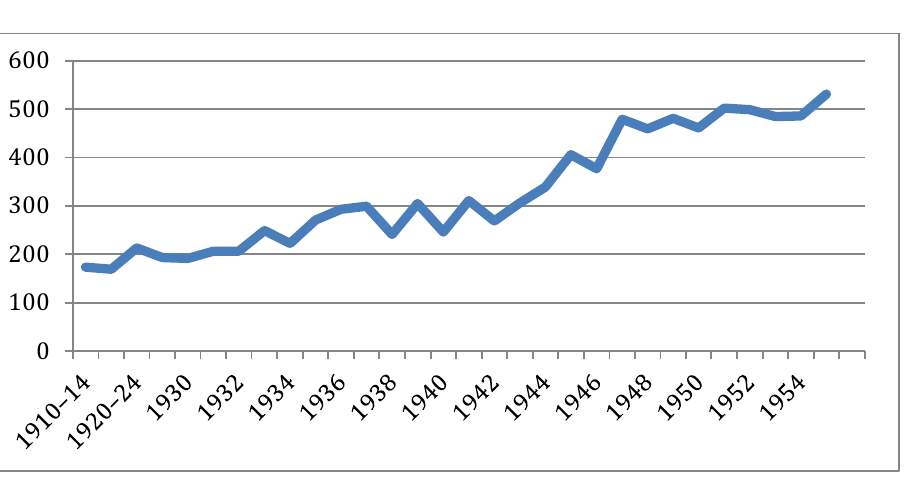
Figure 2. University diplomas in engineering at KTH and Chalmers 1910–1955. Adapted from 1955 års universitetsutredning